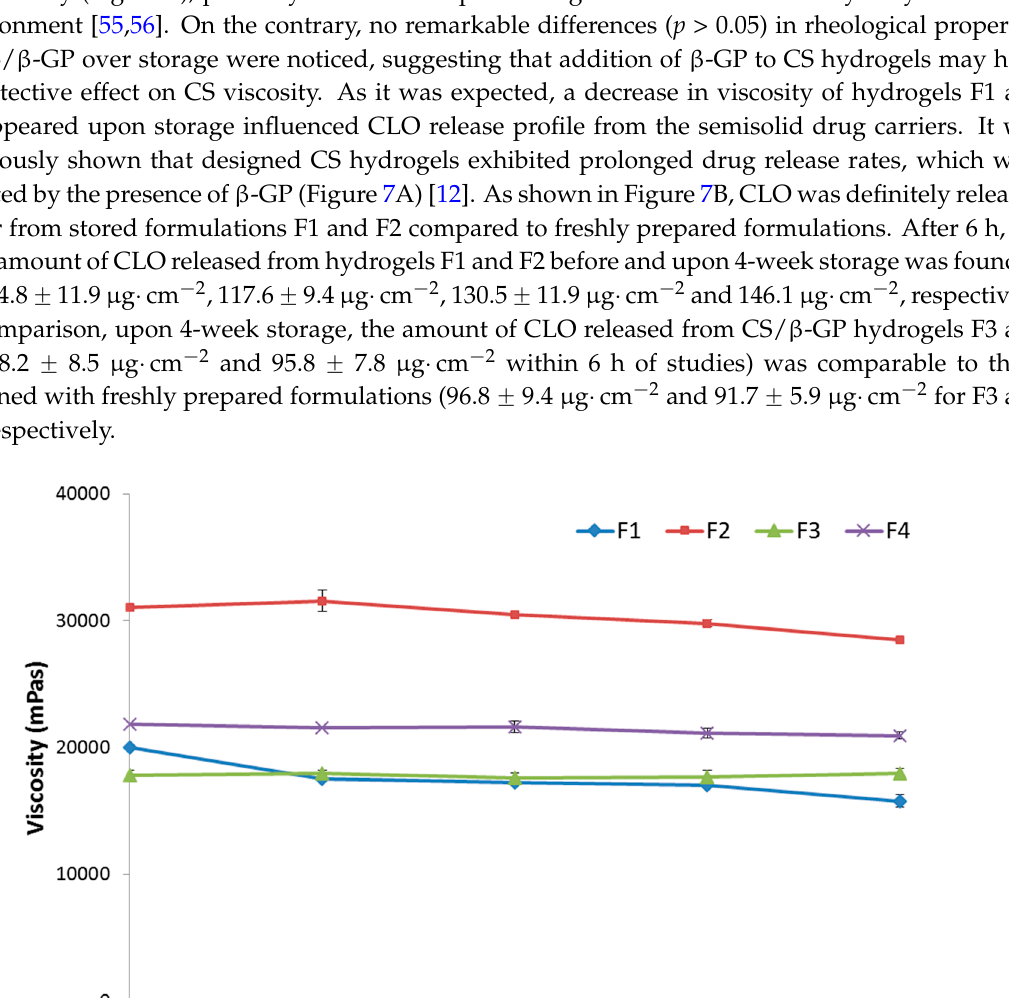
( A ) Figure 7. Cont.